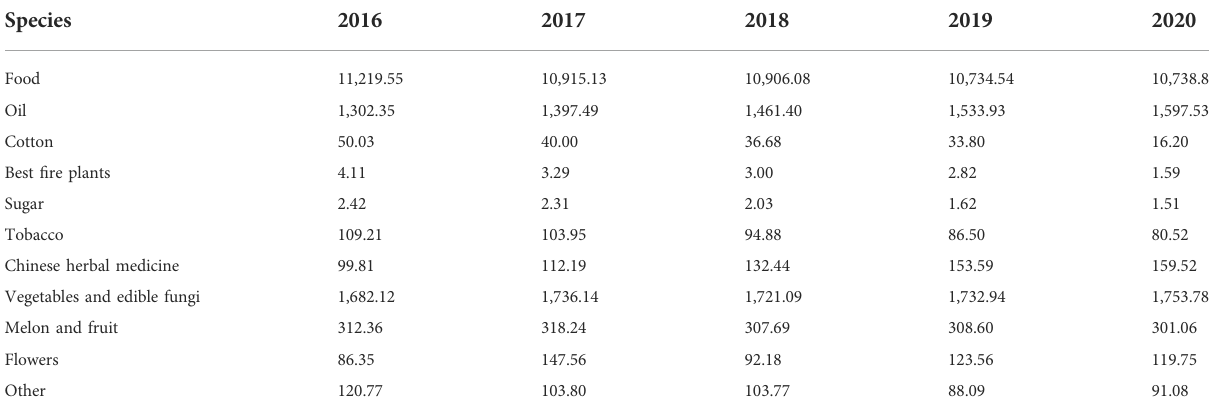
TABLE 1 Sown area of crops in Henan Province from 2016 to 2020.